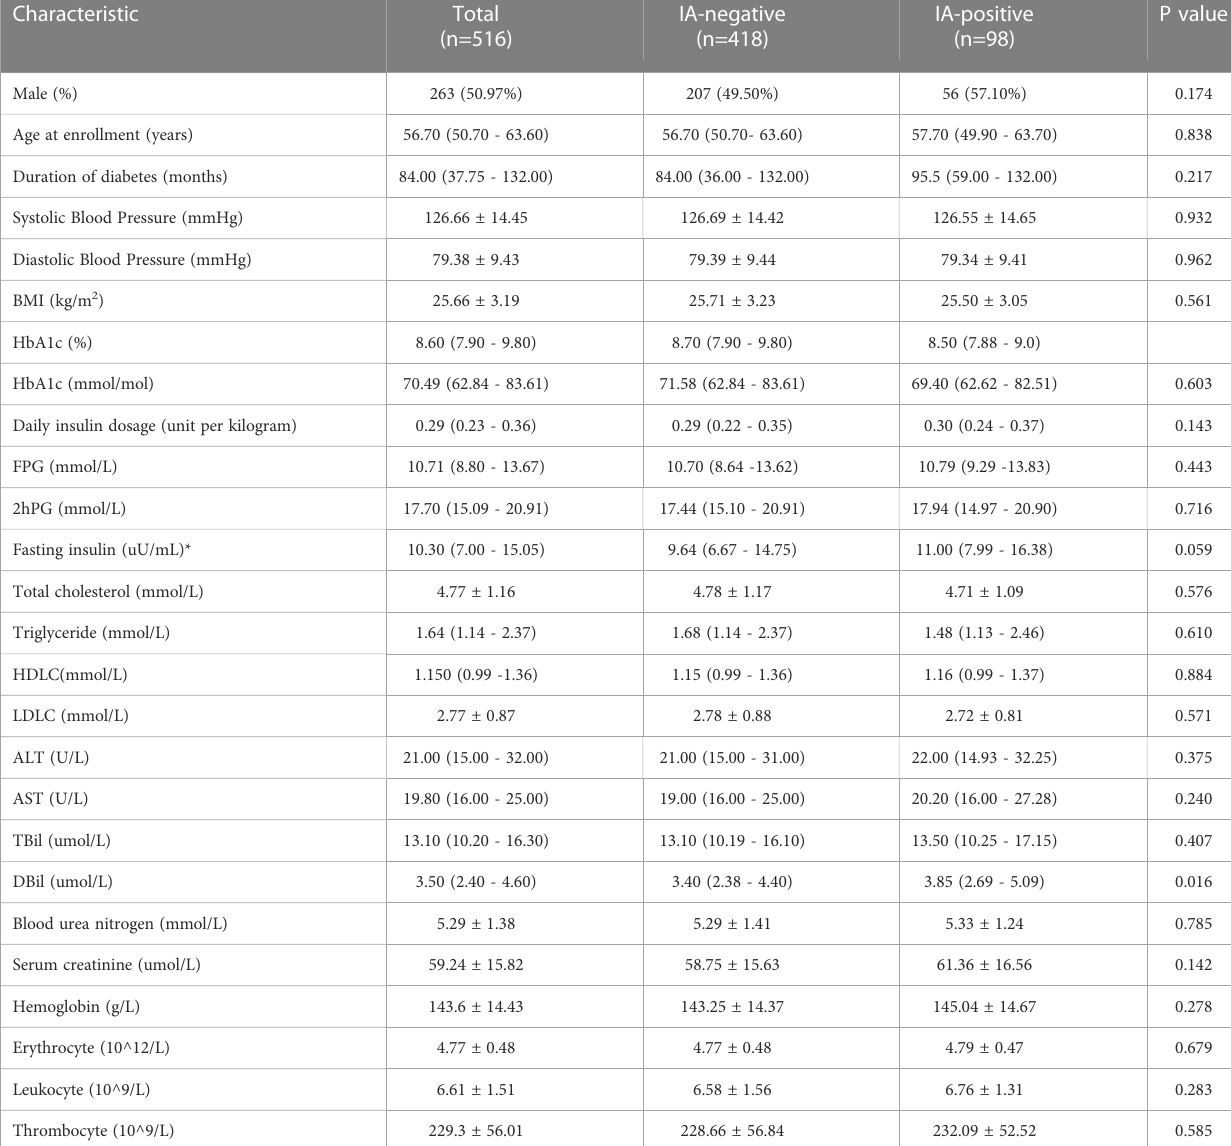
TABLE 1 Clinical and demographic characteristics of the study population beforeinsulin therapy